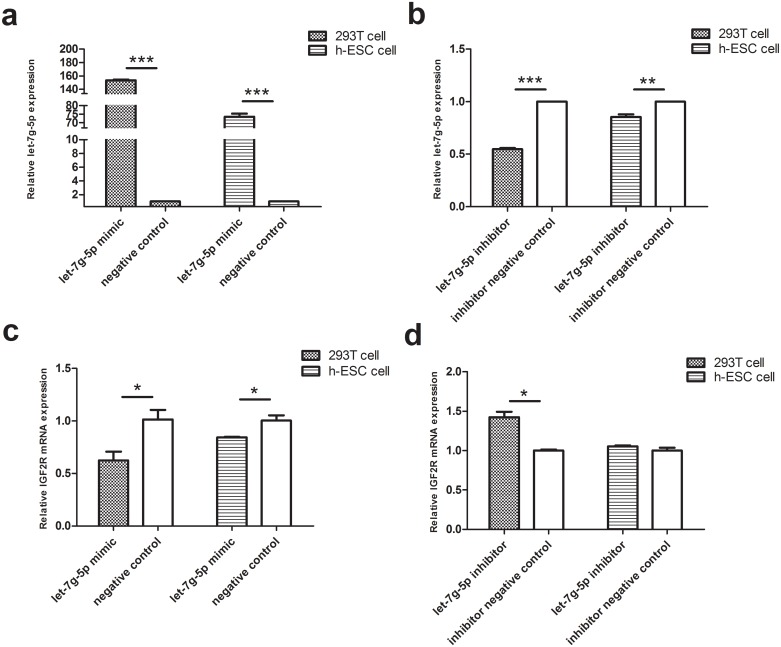
IGF2R expression in vitro after overexpression or knockdown of let-7g-5p.(a) Overexpression of let-7g-5p in HEK293T and hESCs cells. Cells were cultured and incubated with let-7g-5p mimic or negative control. Levels of let-7g-5p were determined using qPCR. (b) Knockdown of let-7g-5p miRNA by transfection with hsa-let-7g-5p inhibitor. Cells were cultured and incubated with hsa-let-7g-5p inhibitor or negative control. Levels of let-7g-5p were determined using qPCR. (c-d) Expression of IGF2R mRNA, as determined using qPCR analysis. Experiments were replicated three times, and error bars represent standard error. *P<0.05, **P<0.01 ***P<0.001.